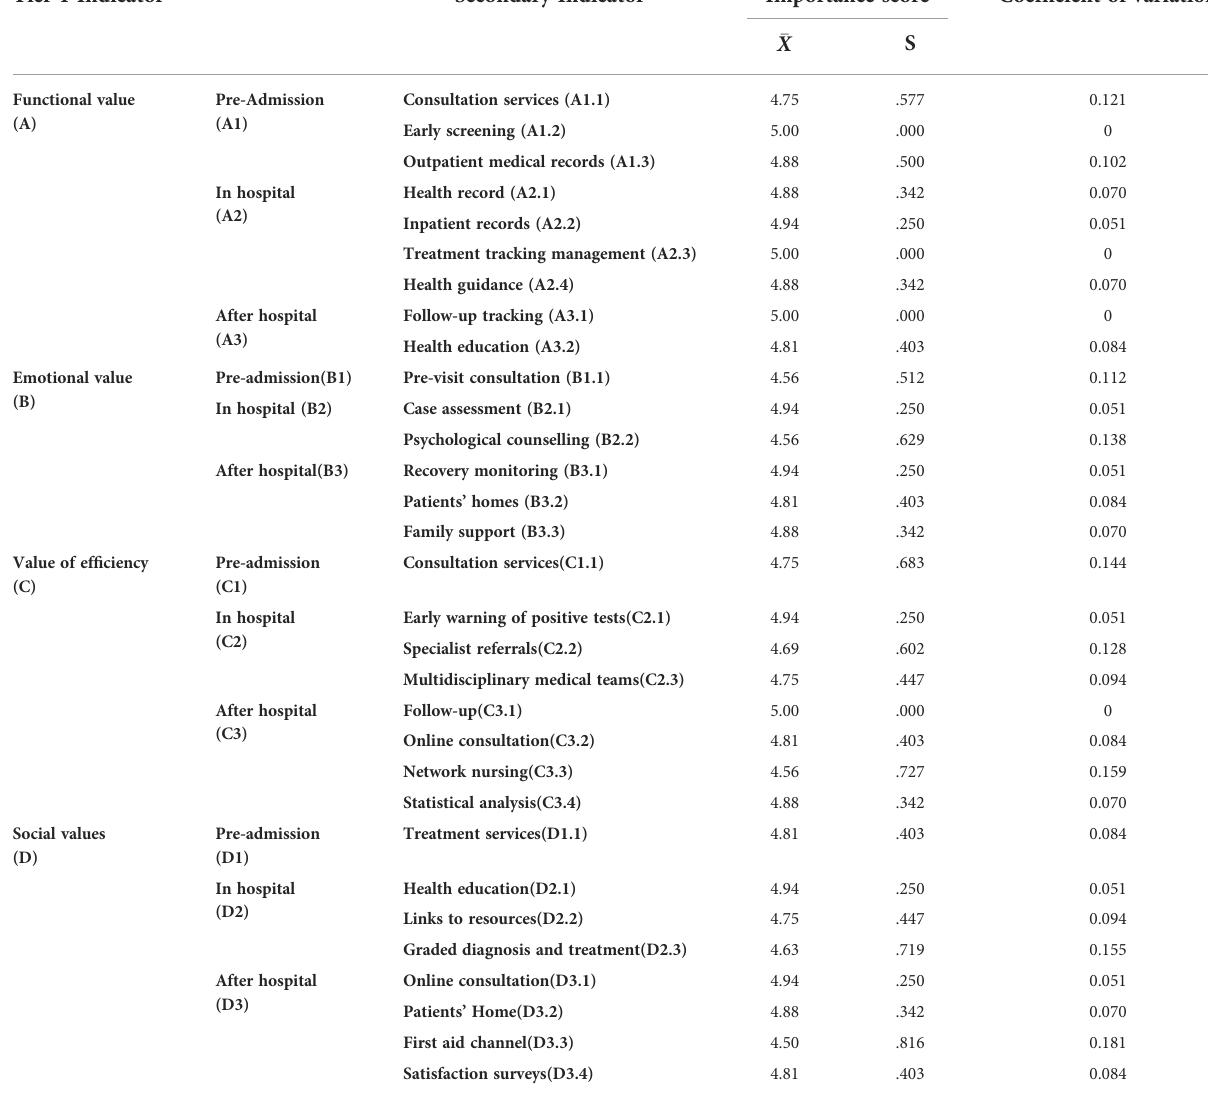
TABLE 5 Evaluation of secondary indicators of the Breast Cancer Case Management Information Platform